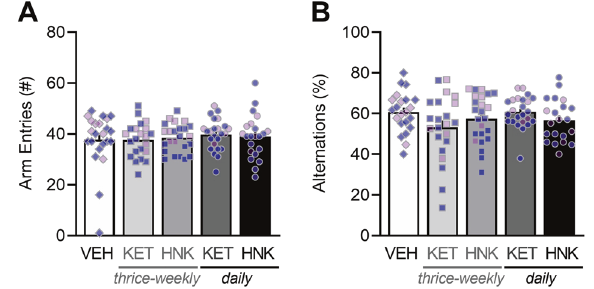
Fig. 5 Working memory is not in fl uenced by ( R,S )-ketamine or ( 2R,6R )-hydroxynorketamine regardless of sex or age of exposure. A Total arm entries and B percent alternations ((the number of alternations/total arm entries − 2) × 100) during the 8-min task. Data are presented as mean ± standard error of the mean.